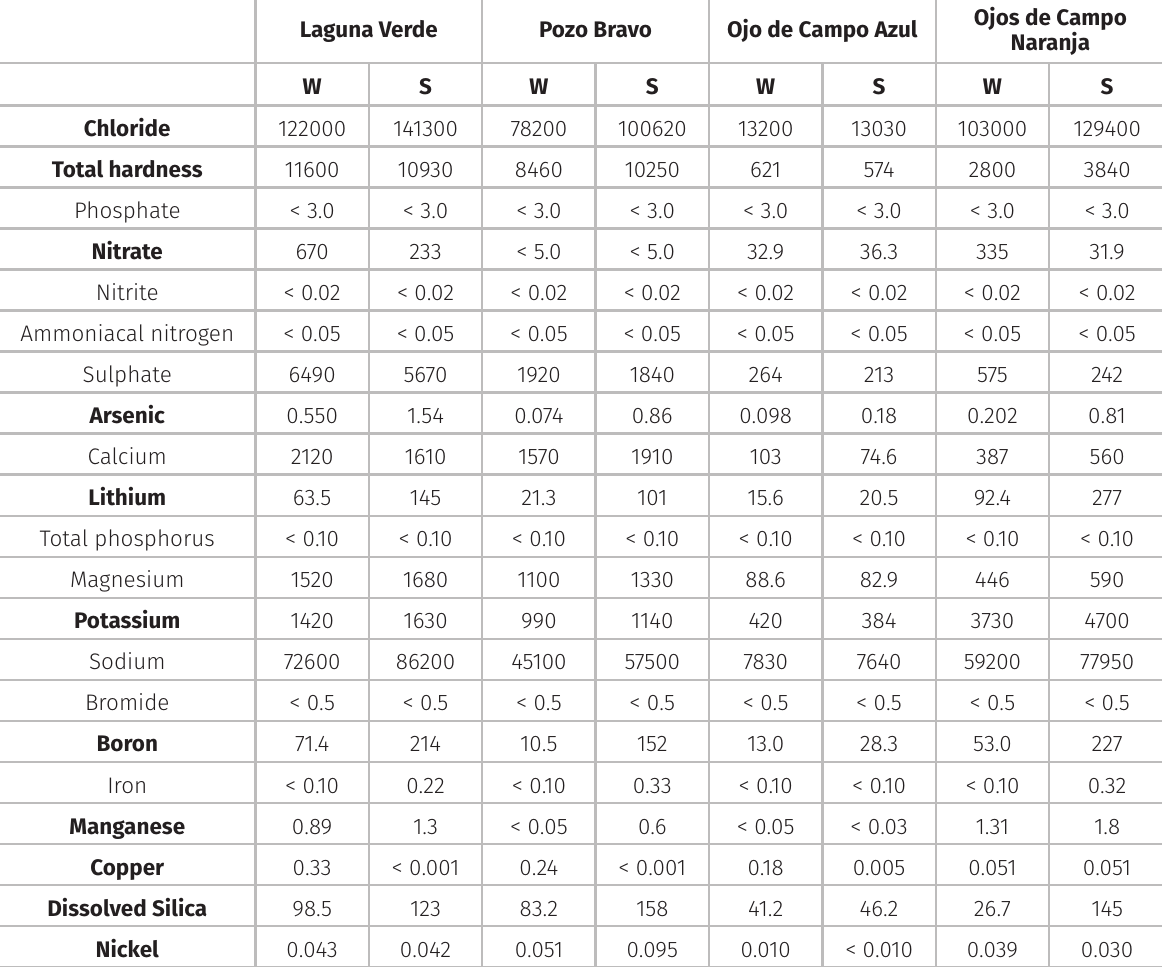
Table II. Main chemical water variables (mg/l) of the four high altitude wetlands analyzed in winter (W) and summer (S). Variables selected for statistical analysis are marked in